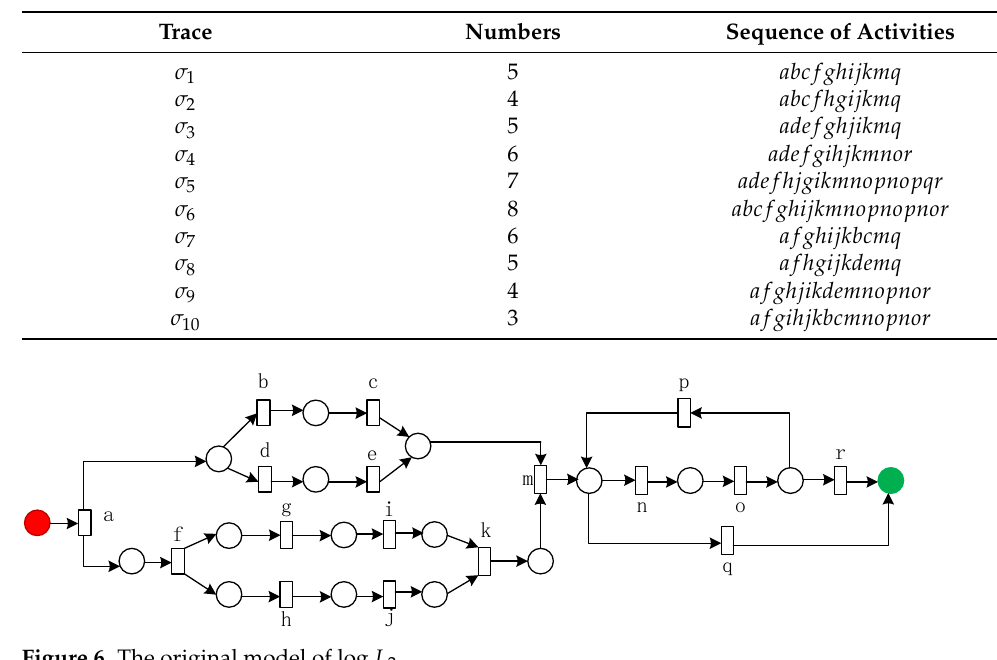
Figure 6. The original model of log L 2 .